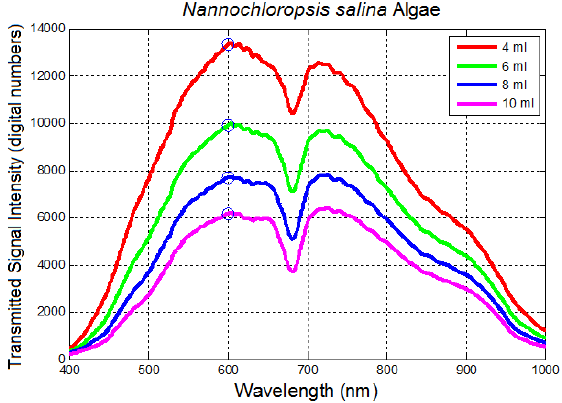
Figure 10. Transmitted signal intensity (average raw spectra) at different volumes of